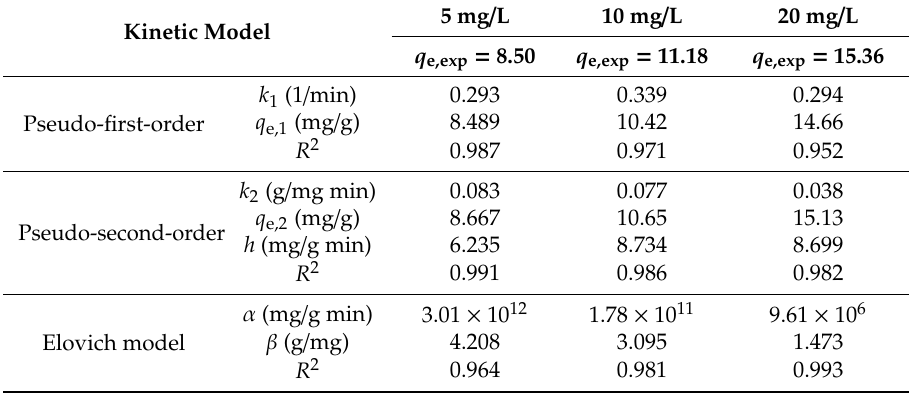
Figure 5. ( a ) Time profiles of Cd(II) adsorption with MGO; ( b ) pseudo-first-order; ( c ) pseudo-second-order; ( d ) Elovich model: m / V = 84 mg/L, pH = 6.00 ± 0.01, C 0(Cd) = 10 mg/L, T = 30 °C. Table 3. Kinetic parameters of Cd(II) sorption on magnetic graphene oxide.